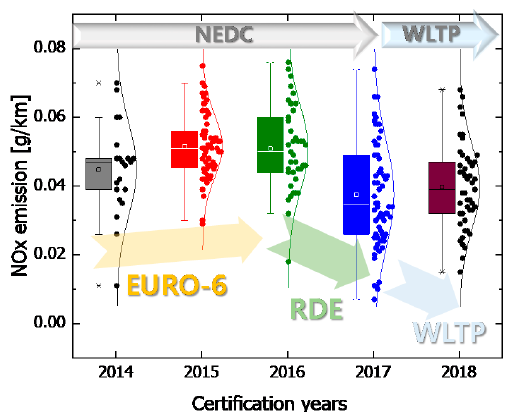
Figure 7. NO x emissions distribution according to certification year (test mode) in light-duty diesel vehicles.